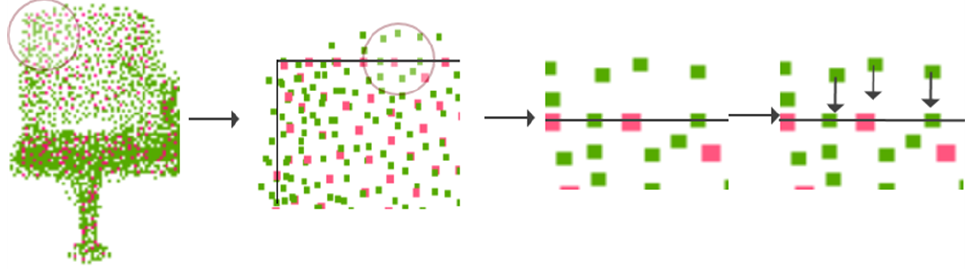
Figure 6. Pull back the overflow point. The green upsampled point cloud exceeds the boundary of the red original point cloud, and this phenomenon causes the boundary of the chair to be blurred. For easier observation, we use circles for partial magnification.